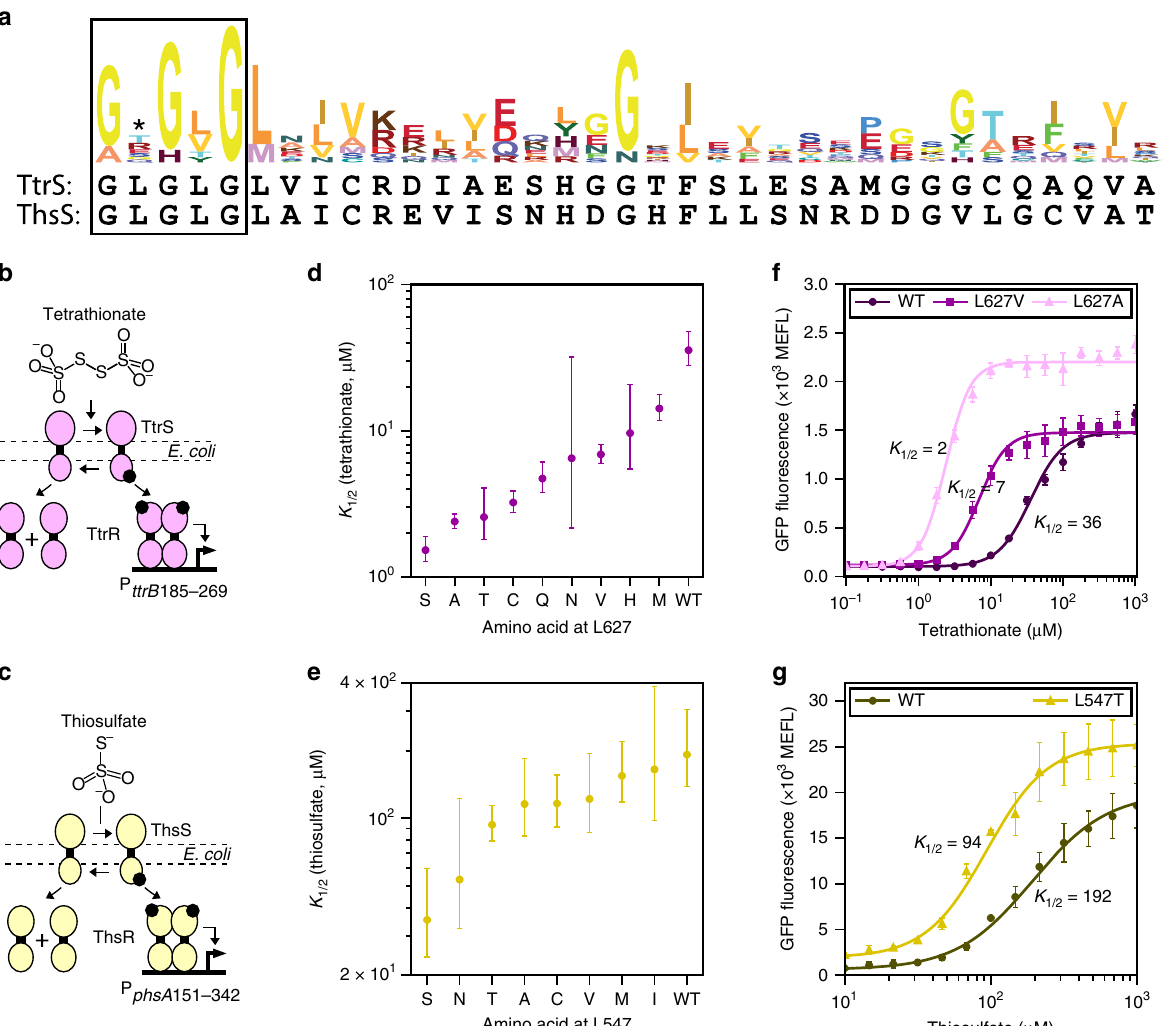
Fig. 5 Identi fi cation of a phosphatase hot spot residue for TCS tuning. a A hidden Markov model (HMM) logo of the SK G2 box (Supplementary Fig. 9), which contains the GXGXG motif (black box). The phosphatase hot spot residue is indicated with an asterisk. The G2 boxes of TtrS and ThsS are shown below the HMM logo. Cartoons of E. coli TtrSR ( b ) and ThsSR ( c ). K 1/2 values of TtrSR ( d ) and ThsSR ( e ) wherein each SK contains the indicated amino acid at the phosphatase hot spot. Points represent the K 1/2 values and error bars the 95% con fi dence intervals of best fi ts to replicates on three different days (Supplementary Figs. 10, 11). f , g Transfer functions of selected TtrSR and ThsSR systems from ( d , e ). Points represent the mean and error bars the SEM of replicates on three separate